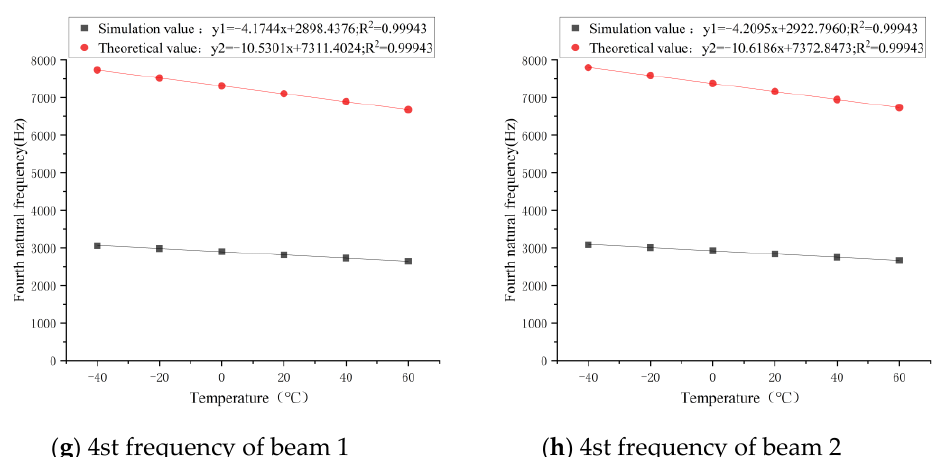
Figure 8. Relationship between the n-grades natural frequency (n = 1, 2, 3, 4) and temperature of the testing beam’s theoretical and simulation results .